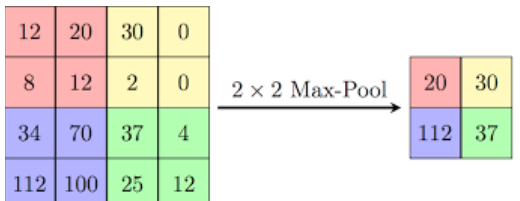
Max pooling in general, is an operation which calculates the maximum, or the largest value in each spot of feature